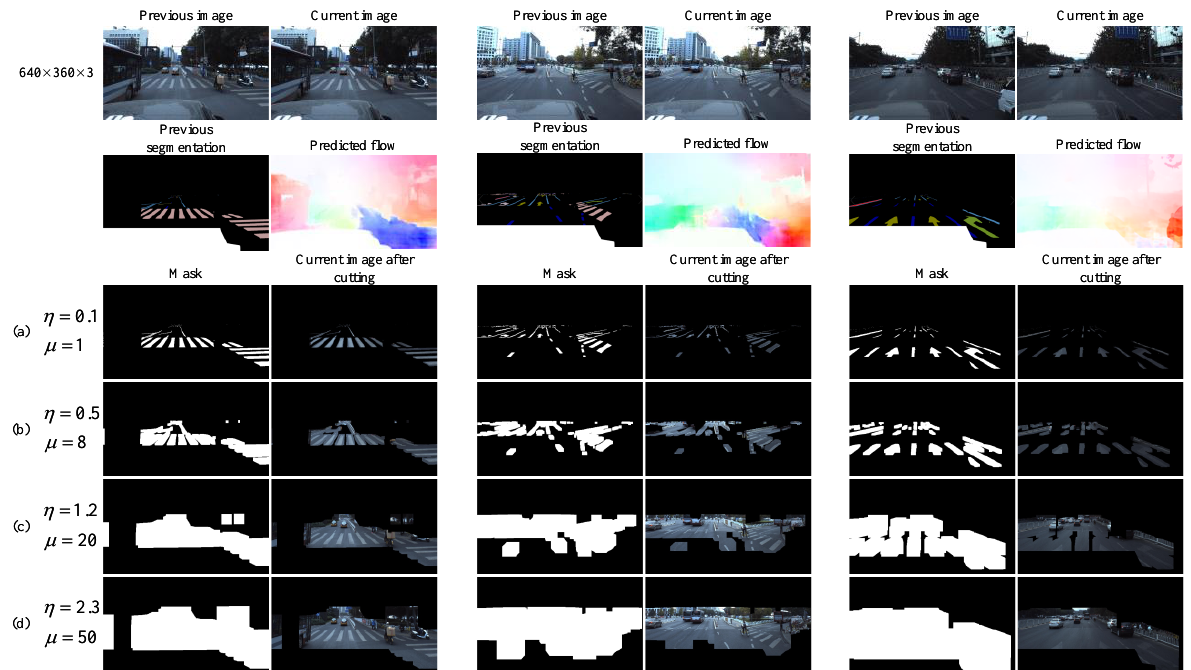
Figure 3. The effect of cropping images with four different dilation kernel sizes. ( a ) The global size of the dilation kernel is approximately 1; that is, the cropped area is approximately equal to the segmentation result of the previous frame. It is obvious that the cropped image cannot cover the target position of the current frame; ( b ) the size of the dilation kernel is expanded, and the cropped image can cover more of the current frame target region, but it has not reached complete coverage. ( c ) Further expanding the size of the dilation kernel, the cropped image can completely cover the target region of the current frame. ( d ) Continue to expand the size of the dilation kernel. Obviously, the cropped image can completely cover the target area of the current frame, but too much redundant background is retained.